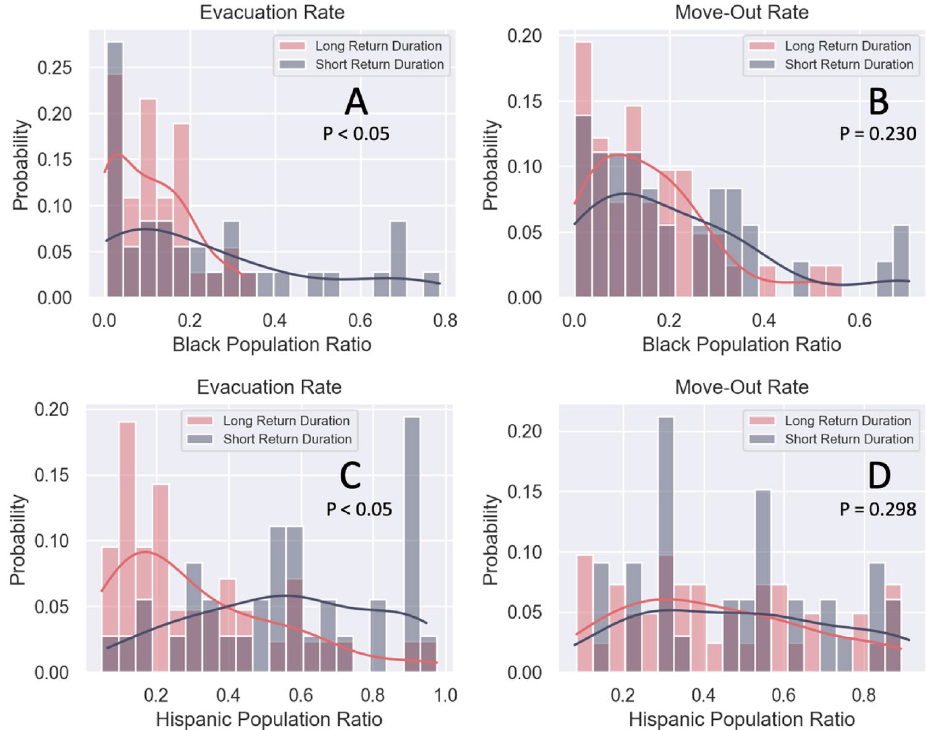
Figure 7. Comparison between long and short return durations with respect to the Black population ratio ( A , B ) and Hispanic population ratio ( C , D ) in the evacuation ( A , C ) and move-out rates ( B , D ). The